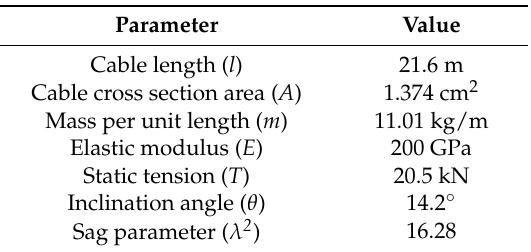
Figure 8. Experimental setup photos for cable vibration control. ( a ) Stay cable ; ( b ) Self-powered MR damper installed on the cable. Table 1. Properties of the model